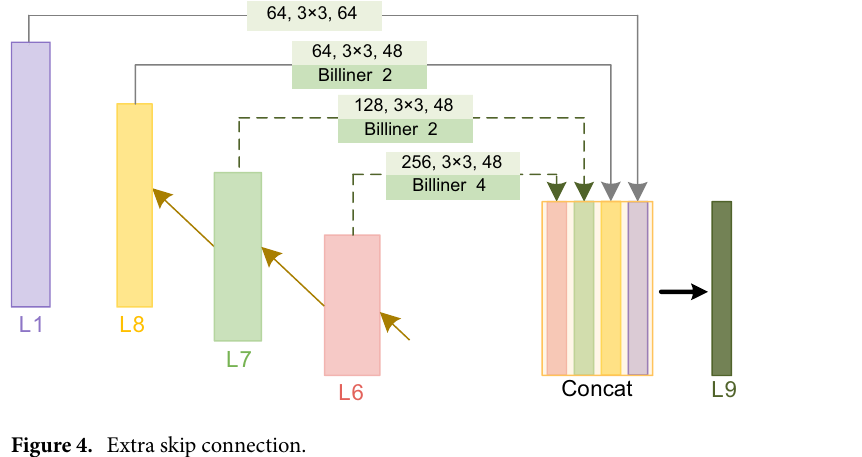
Figure 4. Extra skip